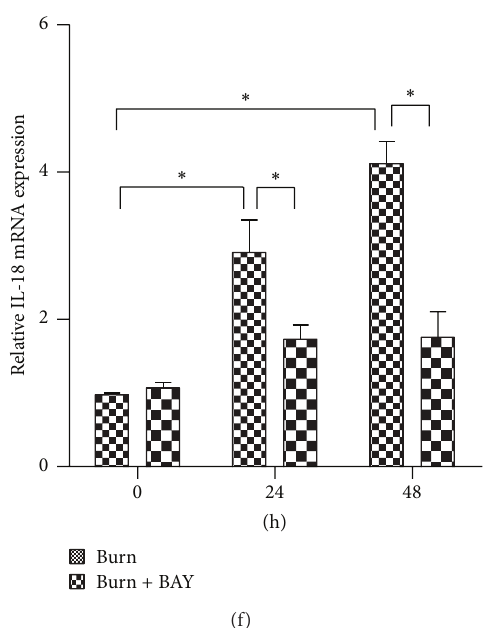
Figure 4: BAY11-7082 alleviated the burn-induced ALI. Rats were subjected to burn injury. BAY11-7082 was administered intraperitoneally immediately after burn injury in rats. At 24 h and 48 h after burn injury, lung tissue was collected. Histopathological changes (a) were assessed by H&E staining and the pulmonary histologic score (b) was counted. Total protein contents in BALF (c) were examined by BCA protein assay kit. The levels of MPO in lung homogenate (d) were tested by MPO kits. IL-1 𝛽 (e) and IL-18 (f) mRNA expression in rat lungs were analyzed by real-time PCR. The values presented are mean ± SEM ( 𝑛 = 6 per group). ∗ 𝑃 < 0.05